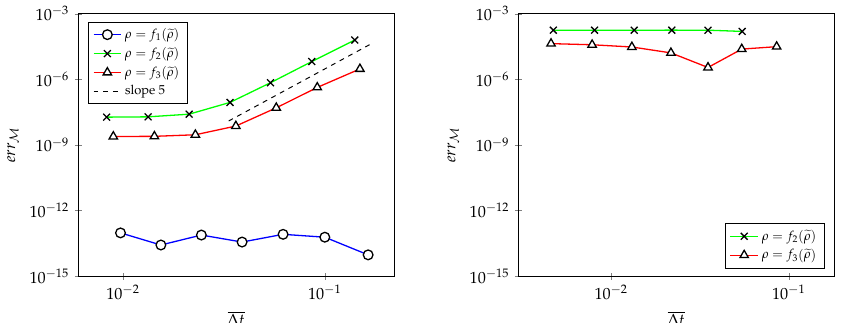
Figure 4. Square density wave advection—mass conservation analysis for each choice of the change of density variable at density ratio r ρ = 2 ( left ) and r ρ = 800 ( right ) using the implicit ESDIRK5(8) scheme. DG polynomial approximation of degree k = 6 on a uniform mesh of 10 × 1 square